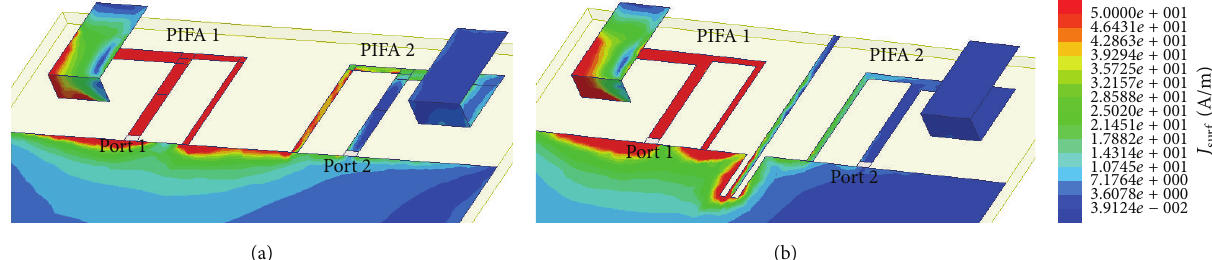
Figure 4: Simulated current distributions for the proposed antenna at 2.4 GHz (port 1: on, port 2: off): (a) without isolator; (b) with isolator.